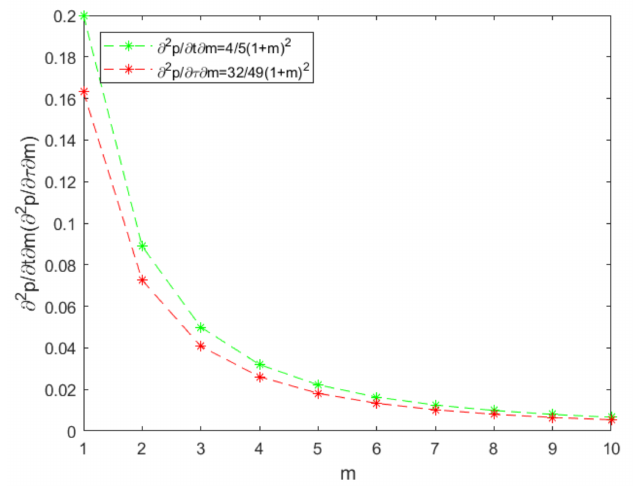
Figure 12. Relationship between rates of change for products in downstream countries with regard to rates of change for a specific duty and ad valorem tax and degree of concentration in down- stream